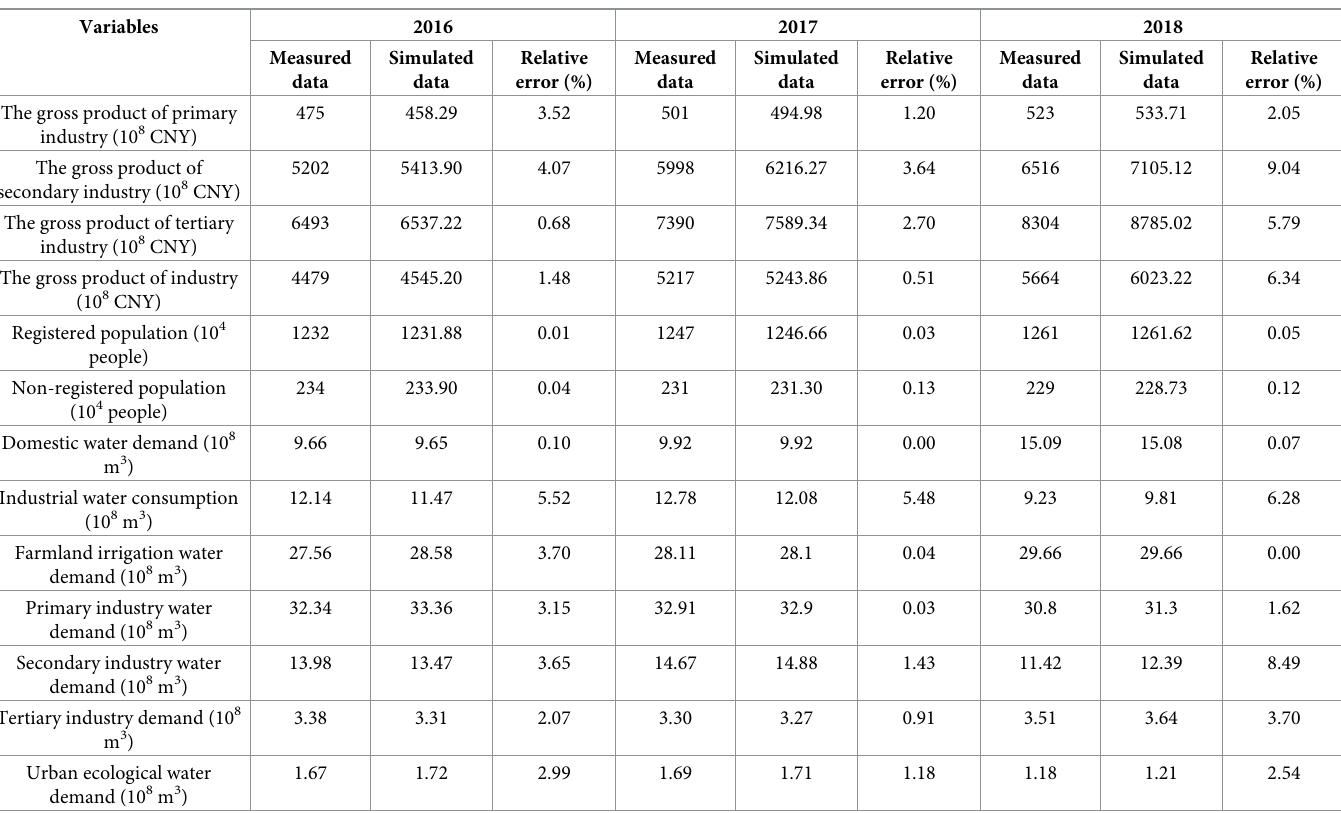
Table 2. Relative errors of the main variables between simulated data and measured